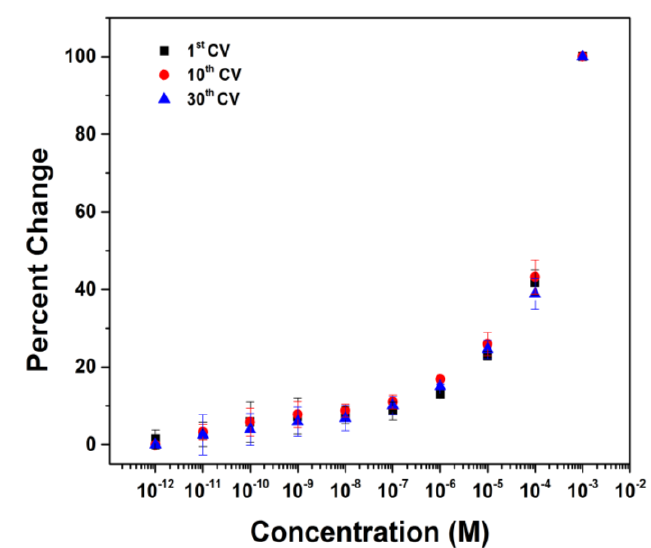
Figure 5. Binding curves generated at different time points.